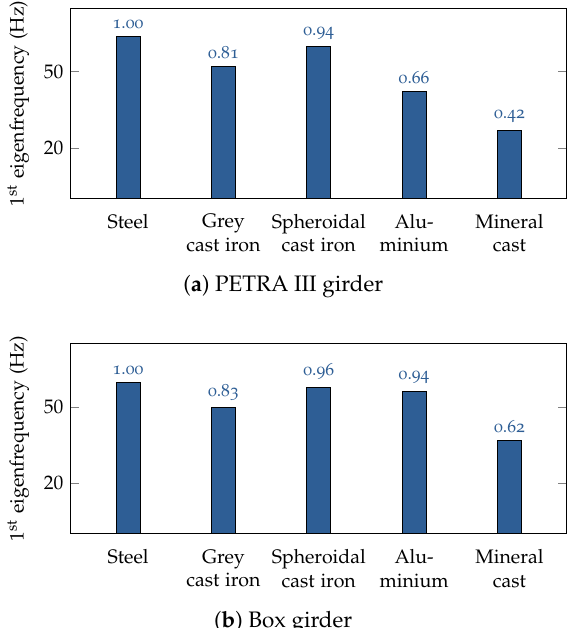
Figure 25. First eigenfrequency of the magnet–girder assembly depending on the material properties of the bases and the PETRA III girder ( a ) and the box girder ( b ). In order to easily see the 1st eigenfrequency deviation compared to steel, the 1st eigenfrequency values were normalised with the corresponding value for S235. The resulting normalised eigenfrequency value is given above each